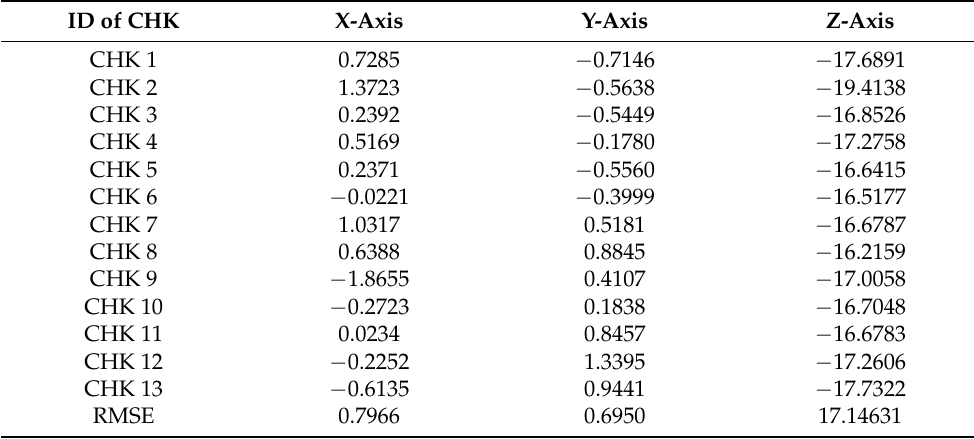
Table 2. Statistical Values for CHKs after the First Experiment (Unit: meter).